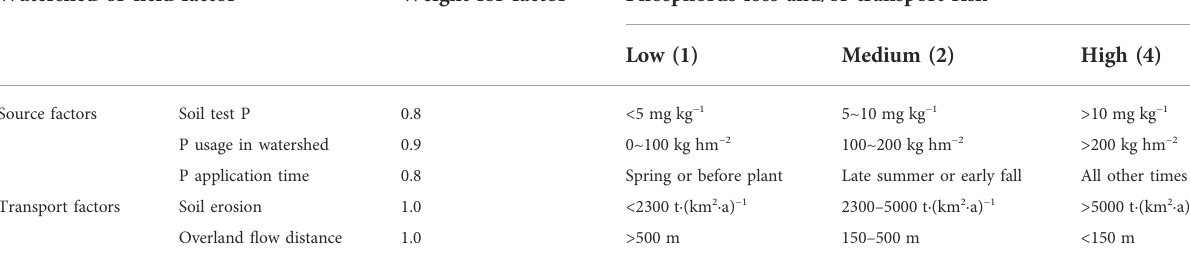
TABLE 3 Risk assessment factors of the phosphorus export in the study watershed.